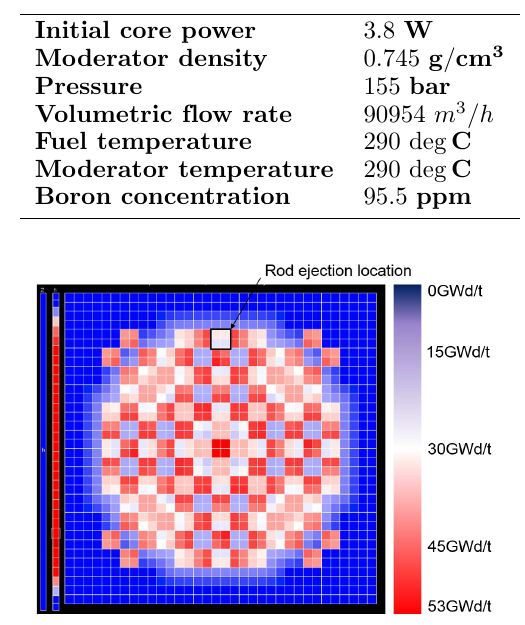
Fig. 3. PWR core burn-up radial distribution in the core.